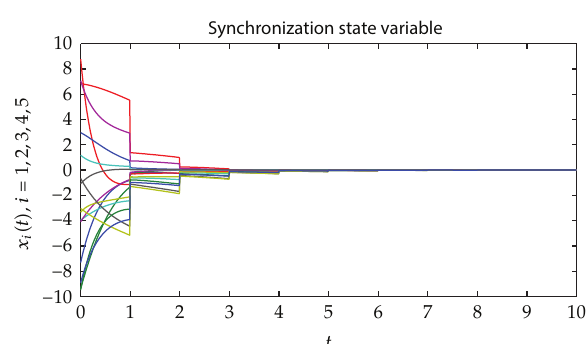
Figure 4: The state variables x i 1 (cid:7) t (cid:8) , x i 2 (cid:7) t (cid:8) , and x i 3 (cid:7) t (cid:8) with impulses.